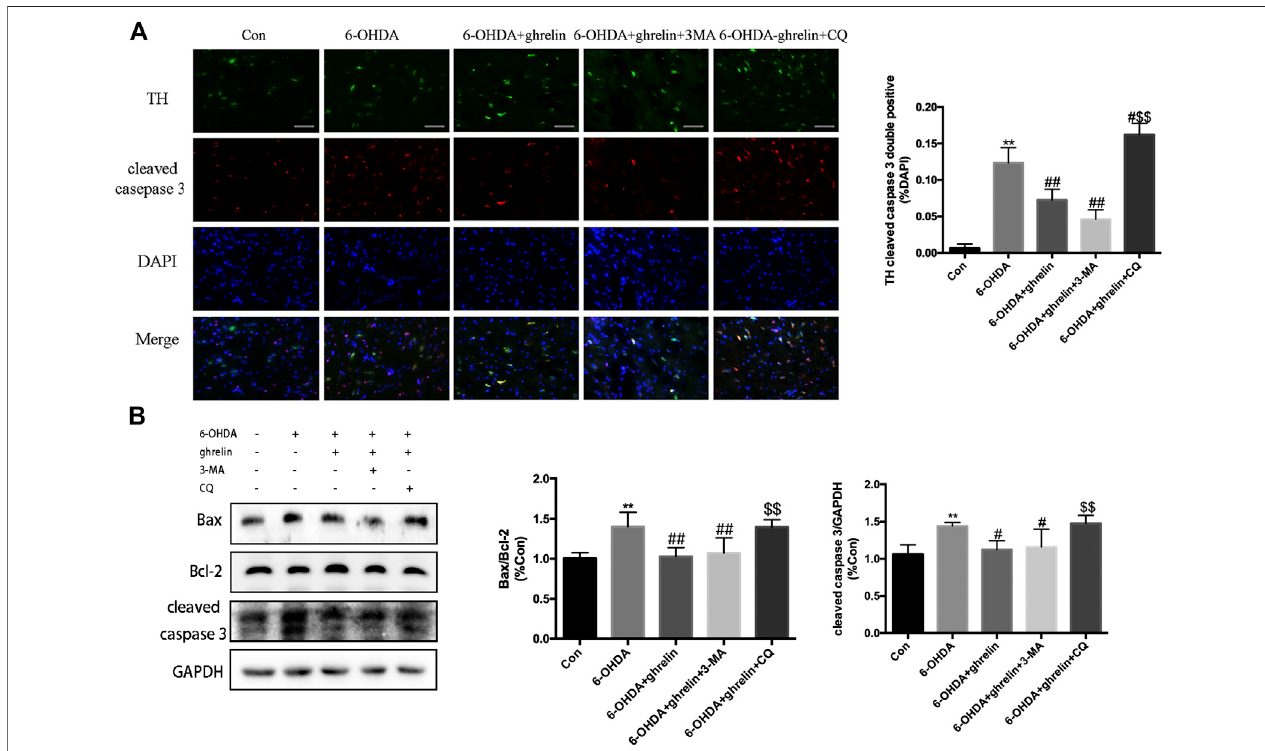
FIGURE 4 | The anti-apoptosis effect of ghrelin is related to autophagic fl ux regulation. (A) Representative double immuno fl uorescence staining and quanti fi cation ofcleavedcaspasethreeandTHintherightsubstantianigra1 dayafter6-OHDAtreatment,scalebar (cid:2) 50 μ m. (B) Representativewesternblotandquanti fi cationofbax, bcl-2andcleavedcaspasethreeintherightSN1 dayafter6-OHDAintoxication;GAPDHwasappliedastheloadingcontrolandforbanddensitynormalization.Dataare presented as mean ± SD; ** p < 0.01 vs. the control group, # p < 0.05 vs. the 6-OHDA group, ## p < 0.01 vs. the 6-OHDA group, $$ p < 0.01 vs. the 6-OHDA + ghrelin group, n (cid:2)